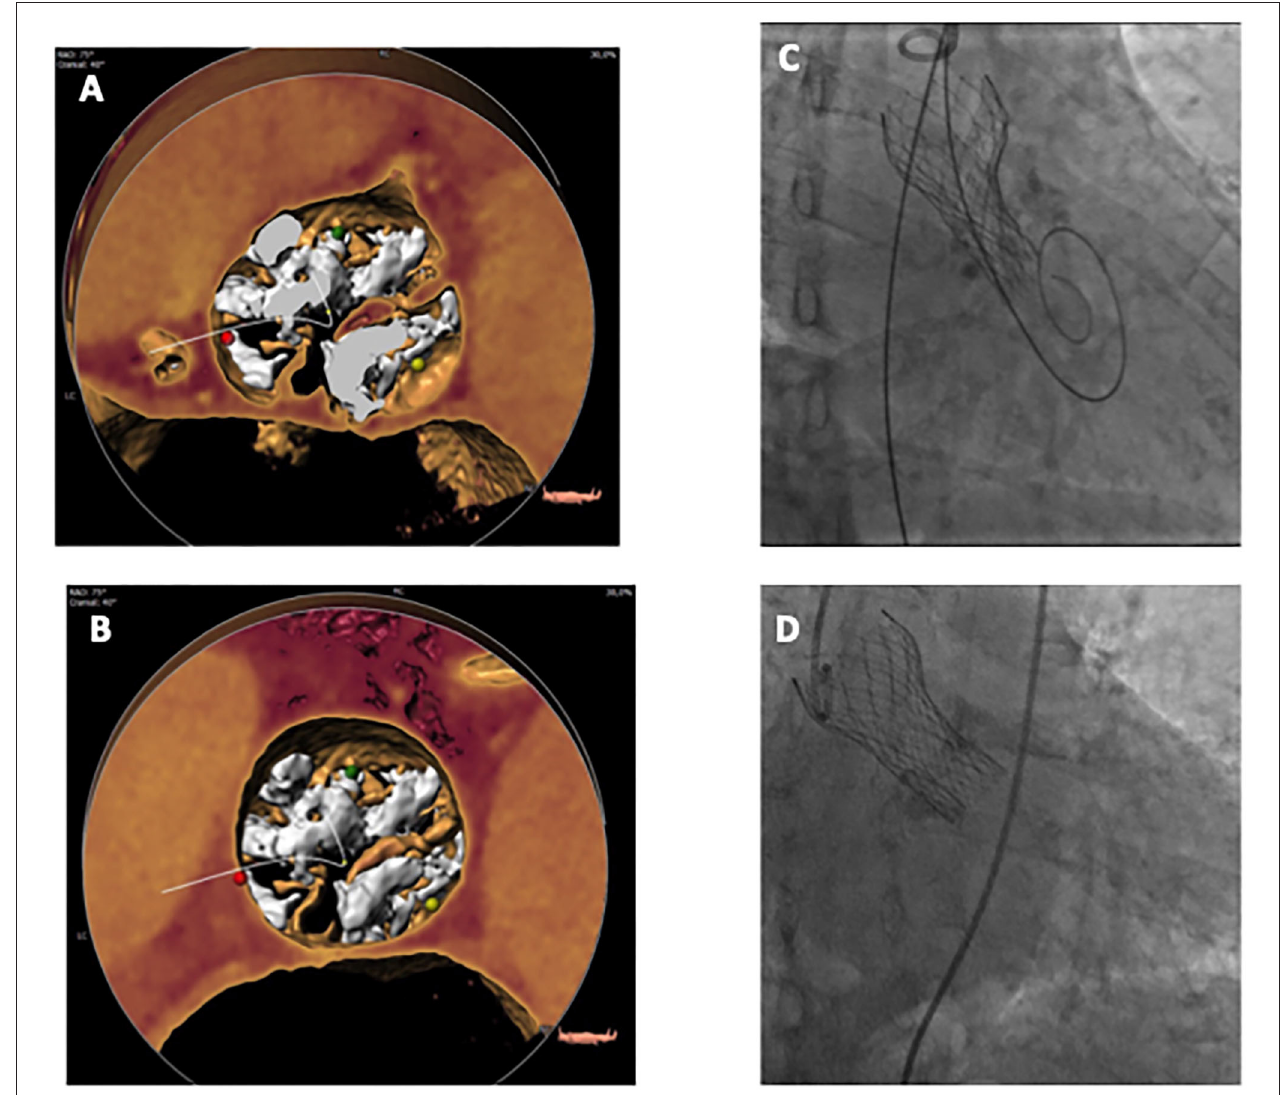
FIGURE 2 | 3D Volume Rendering MSCT view of a BAV at annulus level (A) and raphe level (B) , in this case at 10.4mm from annulus plane. Constrained THV right after release (C) and final result after post-dilatation (D) . BAV, bicuspid aortic valve; MSCT, multislice computed tomography; THV, transcatheter heart